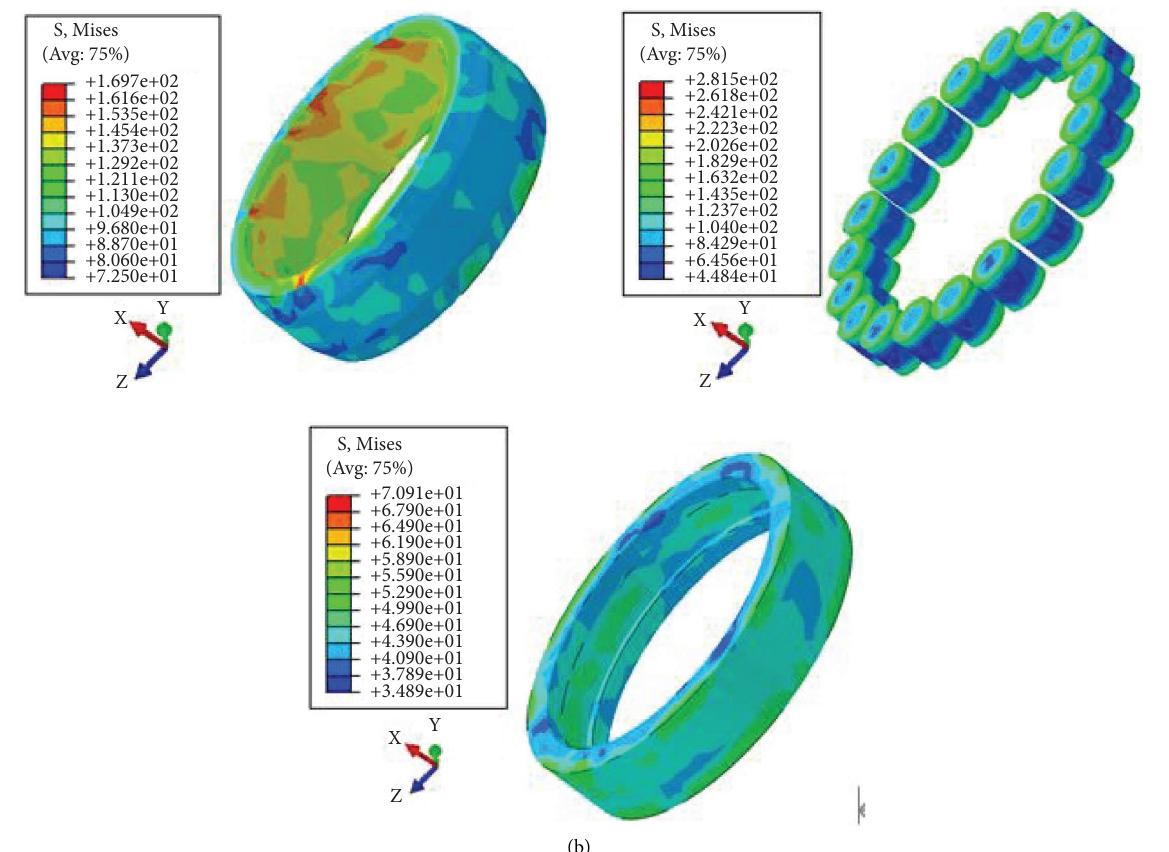
Figure 11: Termal stress distribution of bearing: (a) without considering the heat of tractor motor stator and rotor and (b) considering the heat of tractor motor stator and rotor (the unit is